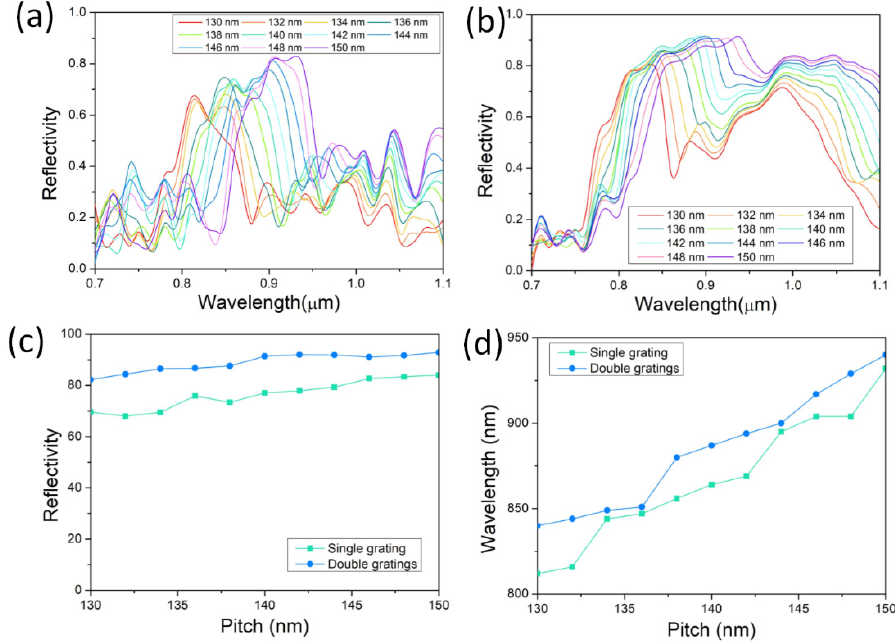
Figure 5. Reflective properties of gratings dependent on pitch. Reflective spectra of various pitch for nanowire ( a ) on single grating and ( b ) sandwiched in double gratings. Comparison of ( c ) reflec- tivity and ( d ) central reflective wavelength between nanowire on single grating and sandwiched in double gratings.